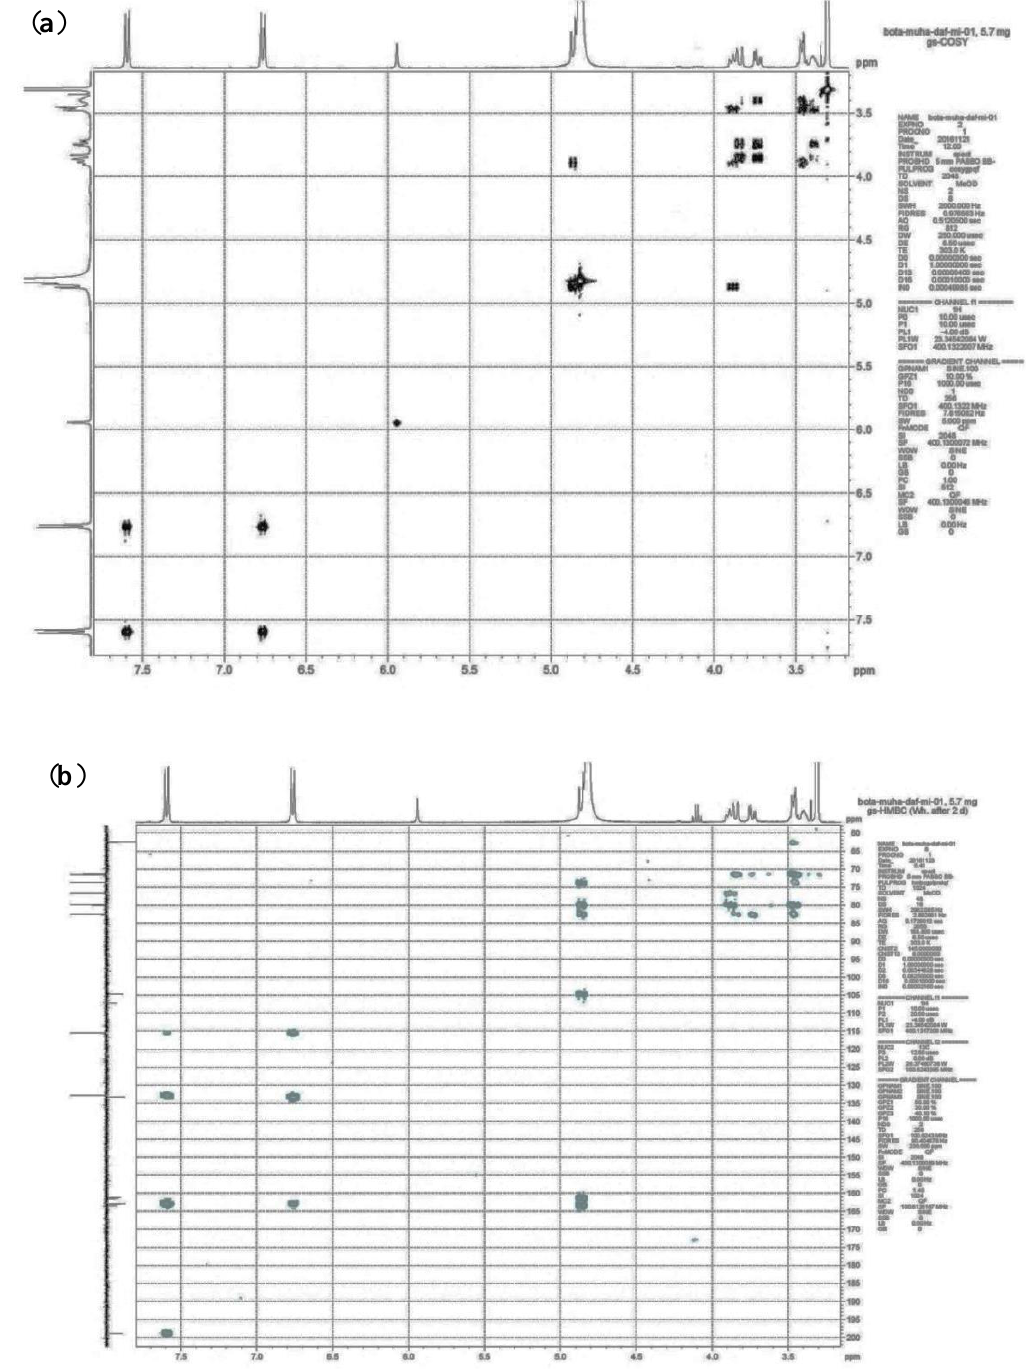
Figure 7. ( a ) gs-COSY spectra of “iriflophenone-3-C- β -D glucopyranoside” isolated from AqF of D. ramosa and ( b ) gs-HMBC spectra of “iriflophenone-3-C- β -D glucopyranoside” isolated from AqF of D. ramosa.